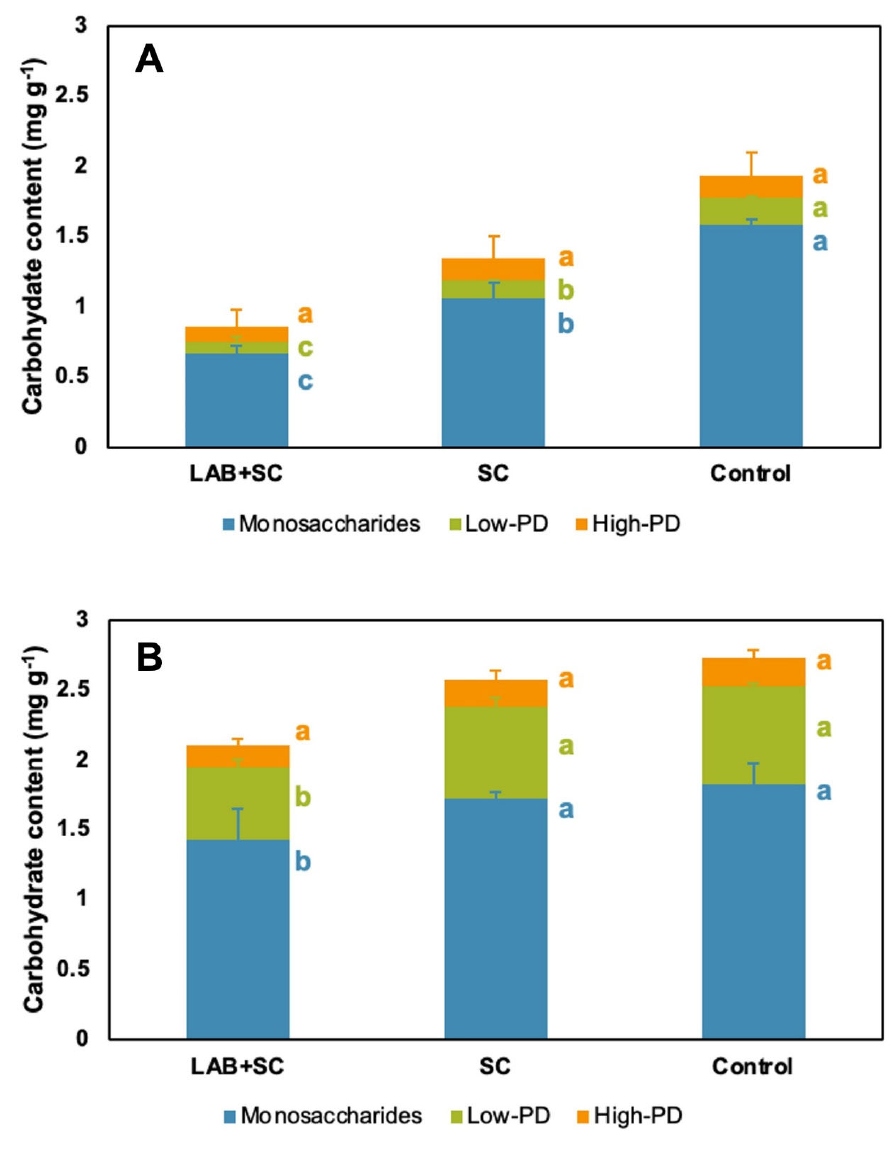
Figure 4. HPAEC-PAD carbohydrate content of rye sourdoughs. Carbohydrate content of native rye doughs ( A ). Carbohydrate content of sprouted rye doughs ( B ). Results are expressed as carbohydrate content (mg g-1) referred as xylose, arabinotriose, and arabinoctaose equivalents for monosaccharides, low-polymerization degree oligosaccharides (low-PD), and high-polymerization degree oligosaccharides (high-PD) contents, respectively ( B ). Vertical bars indicate standard deviation ( n = 6). Different letters indicate statistically significant differences ( p < 0.05) among treatments.